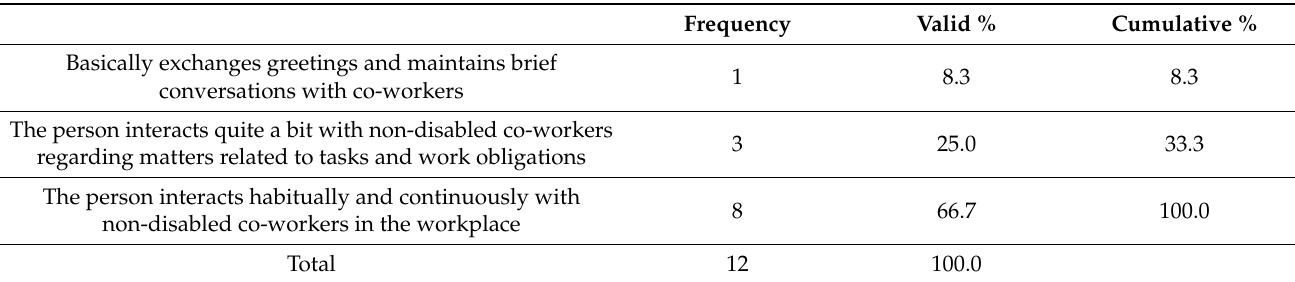
Table 10. Integration in the